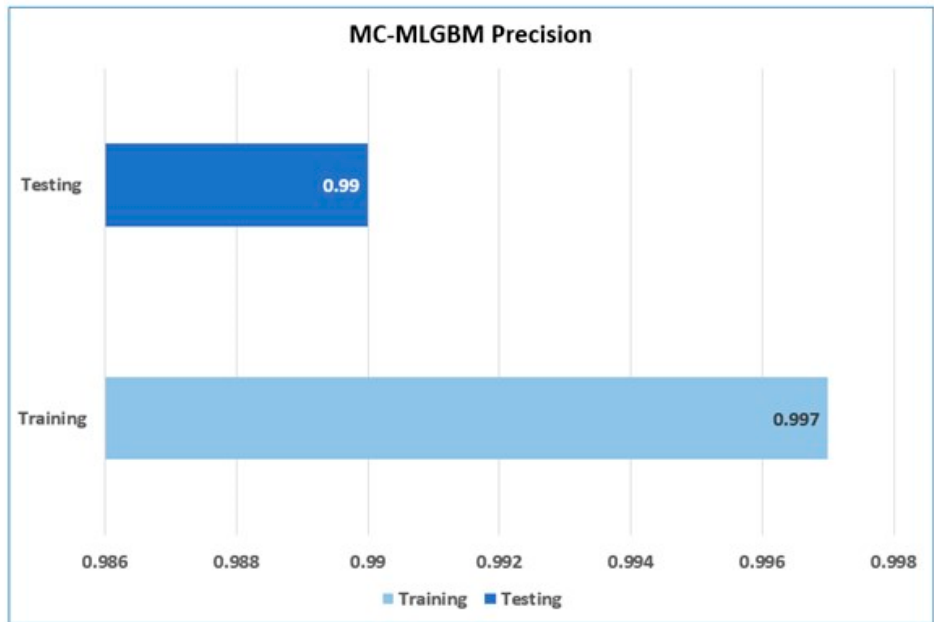
Figure 6. Training and testing precision of the proposed model.